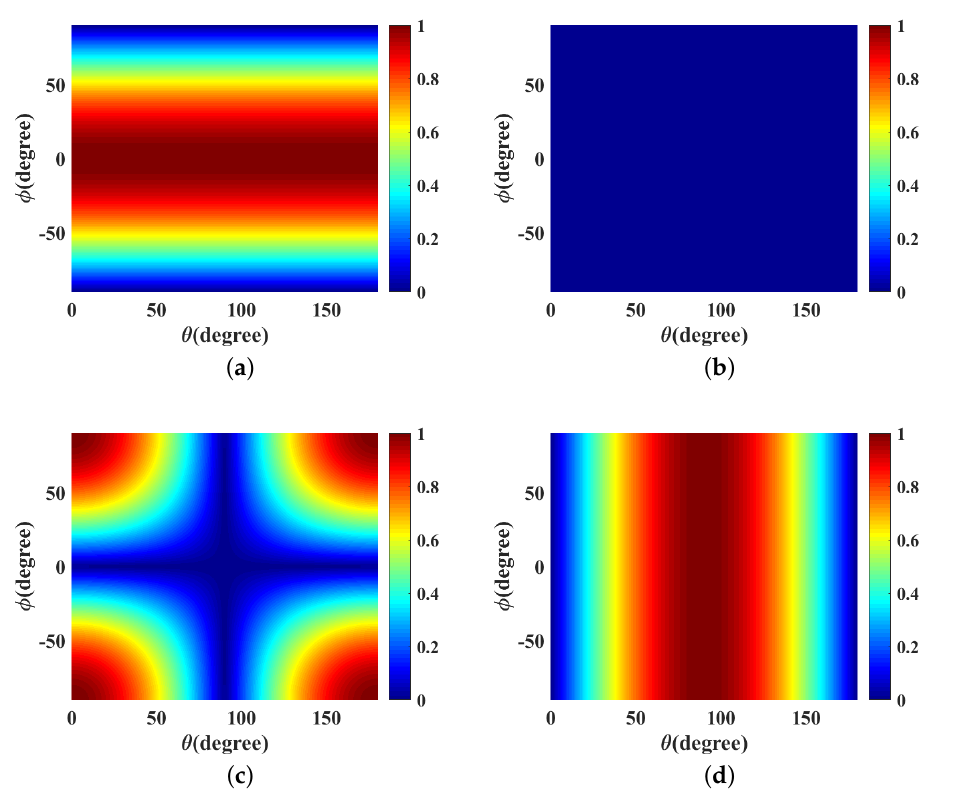
Figure 2. Copolar and cross-polar electric fields for horizontally and vertically polarized dipoles. ( a ) co-polarization pattern of a horizontally polarized dipole; ( b ) cross-polarization pattern of a vertically polarized dipole; ( c ) cross-polarization pattern of a horizontally polarized dipole; ( d ) co-polarization pattern of a vertically polarized